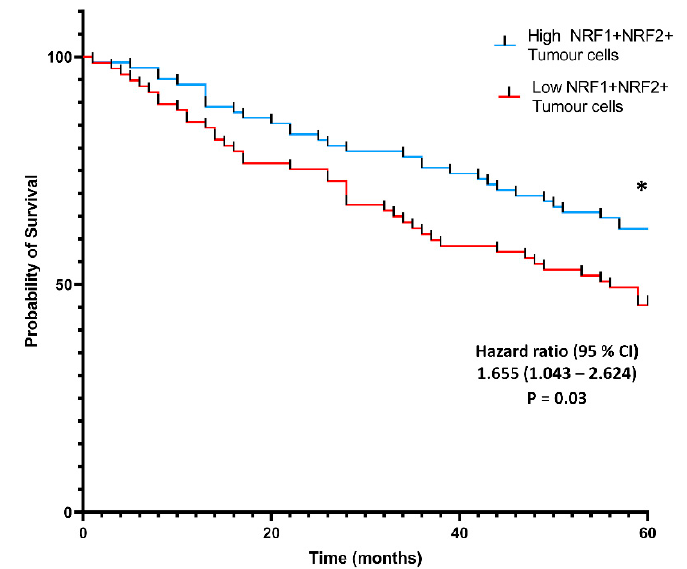
Figure 4. Kaplan–Meier survival analysis of the density of NRF1 and NRF2 co-expressed cancer cells. Population-based Kaplan–Meier five-year survival analysis demonstrates the association between NRF1 + NRF2 + co-expressing tumor cells and the probability of survival. Statistical significance was assessed using the log-rank test (Mantel–Cox). ( p * <